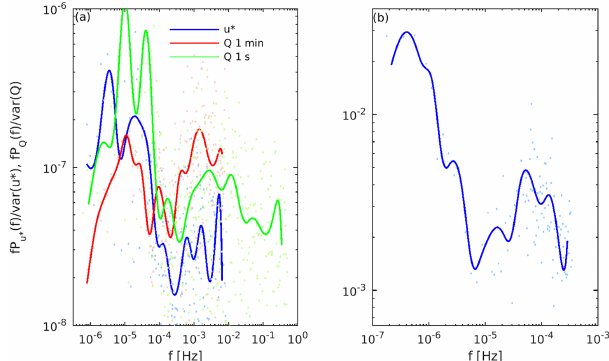
Figure 7. (a) Normalised power spectrum of u ∗ (blue) computed with u ∗ 1min , together with the normalised power spectrum of salta- tion flux computed with Q 1min (red) and Q 1s (green). (b) Nor- malised Q − u ∗ co-spectrum, computed using with Q 1min and u ∗ 1min . In both (a) and (b) , dots are unsmoothed spectra, and curves are smoothed